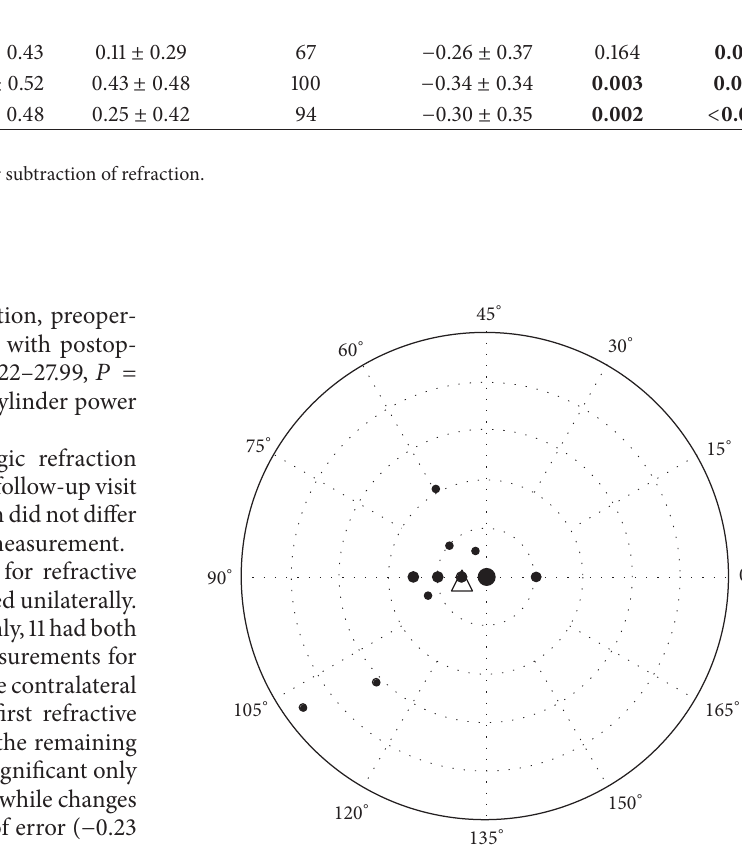
Figure 1: A double-angle, plus cylinder power plot for surgically induced astigmatism. ∗ Rings equal 0.5 D steps (inner ring = 0.5 D; outer ring = 2.5 D). Size of points represents number of cases with same cylindric change. △ = centroid 0.25 ± 0.42 D × 94 ∘